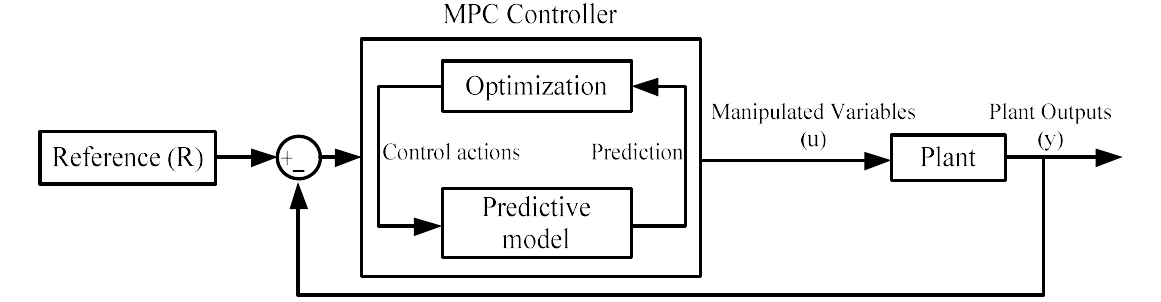
Figure 2. MPC controller mechanism.